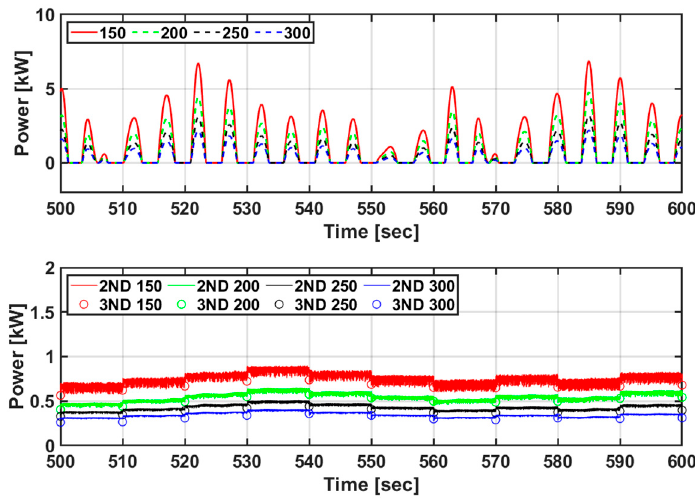
Figure 19. Comparison of the amount of power generated according to the initial rpm of the speed control algorithm under irregular wave conditions ( H s = 0.75 m, T p = 4.75 s) (legend indicates initial